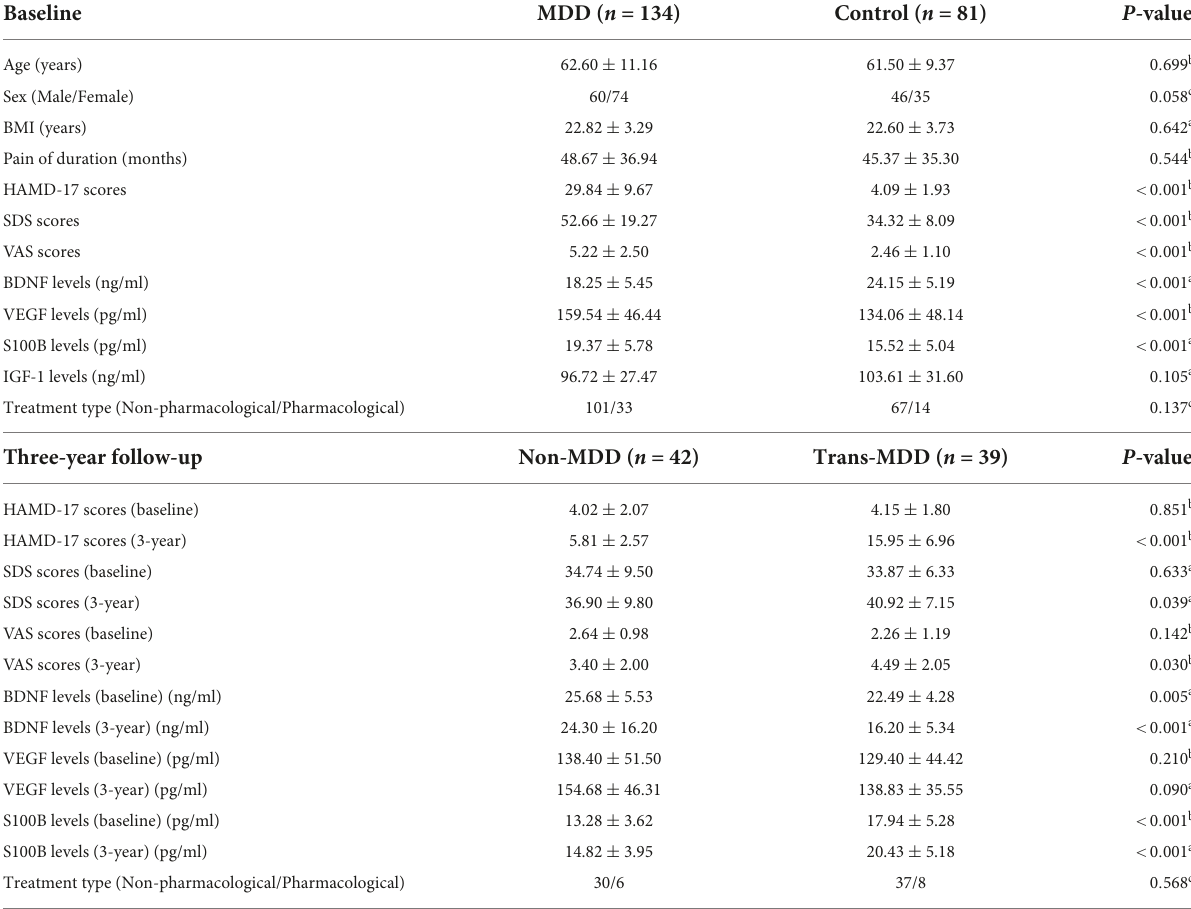
TABLE 1 The clinical features and serum levels of neurotrophins in knee OA patients at baseline and after 3-year follow-up.